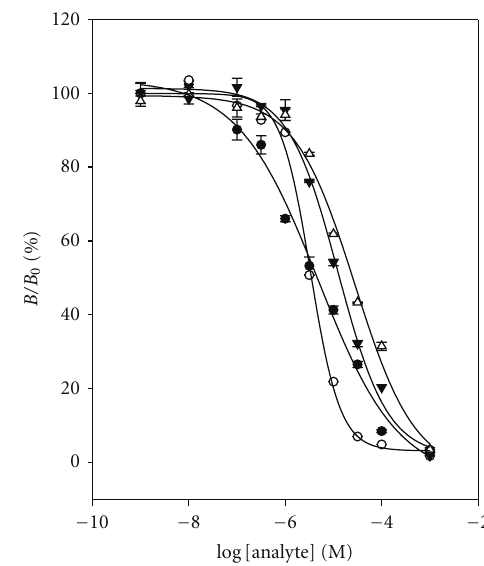
Figure 4: Cross-reactivity study with DNA aptamer for cross- reactants: ( • ) TC, ( ◦ ) OTC, ( (cid:3) ) CTC, and ( (cid:5) ) DC. Data points are means of triplicate